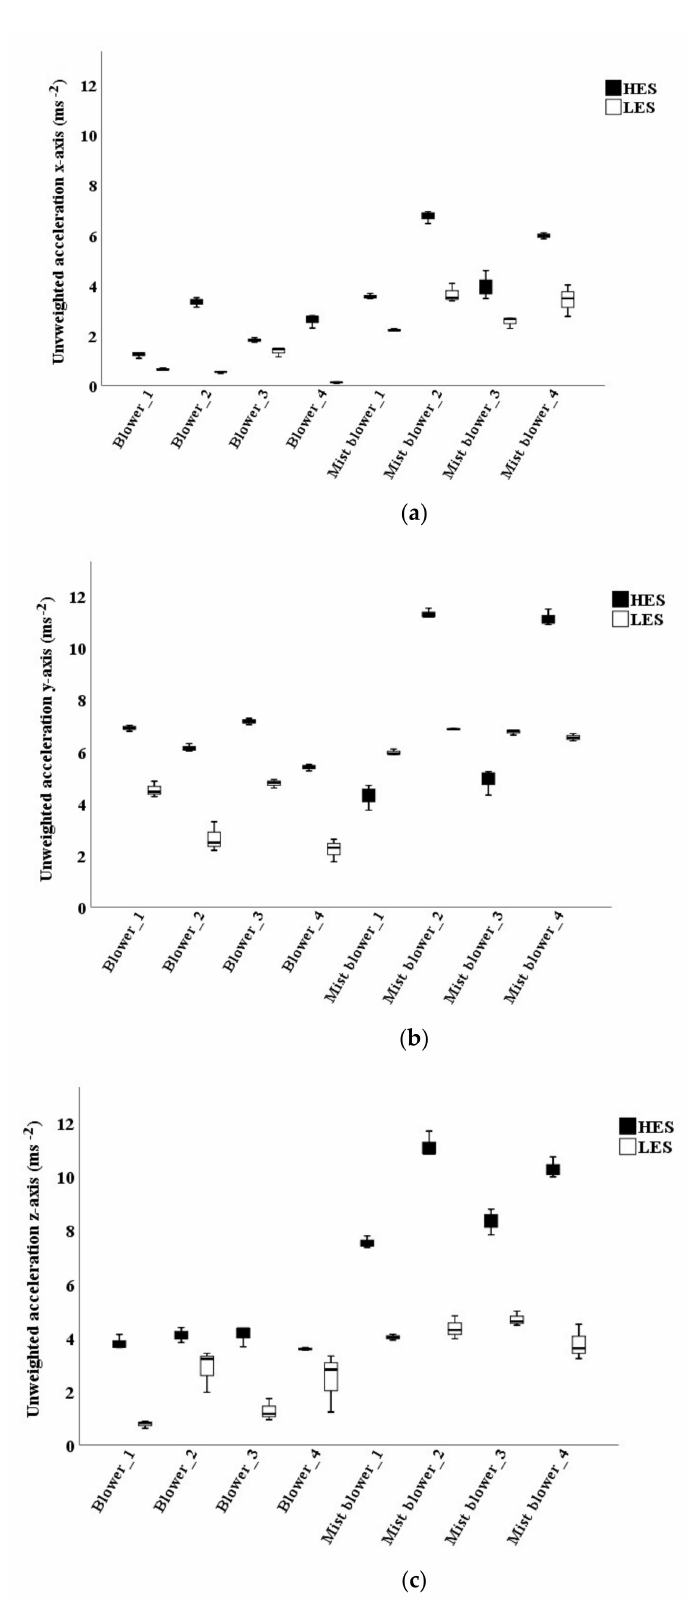
Figure 5. Unweighted accelerations measured on the operators’ back along the axes. ( a ) x -axis; ( b ) y -axis; ( c ) z -axis. LES: low engine speed; HES: high engine